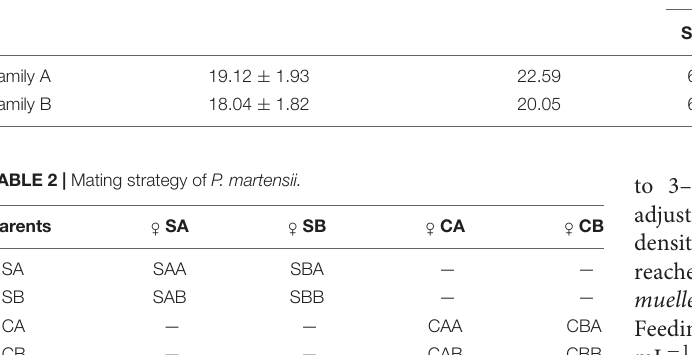
FIGURE 1 | Shell width frequency distribution of P. martensii : (A) Family A and (B) Family B. TABLE 1 | Shell width (mean ± SD) of base populations and selected group parents, cutoff points, and selection intensity of P. martensii. Items Base population shell width (mm) Cutoff point (mm) Selected parents Selection intensity